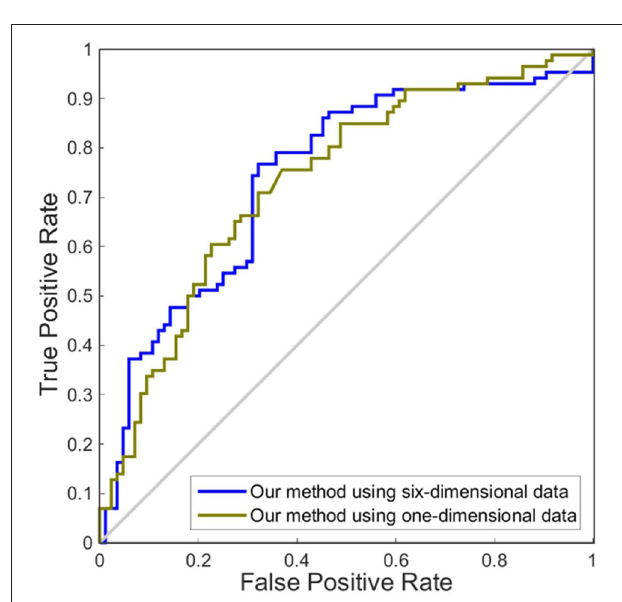
FIGURE 7 | ROC curves of our method using different dimensions of original features to distinguish sMCI and pMCI. The different line colors represent ROC curves of our method of constructing individual morphological brain networks based on different dimensional features. ROC, receiver operating